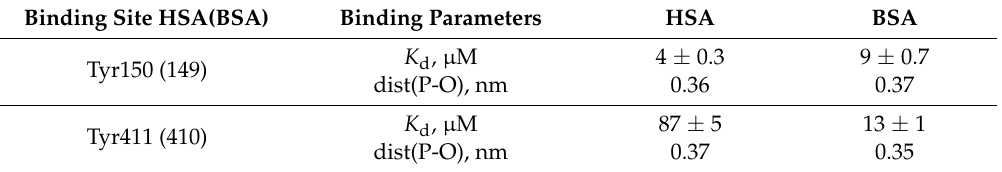
Table 3. The result of molecular docking of paraoxon into the sites Tyr150 (149) and Tyr411 (410) of HSA and